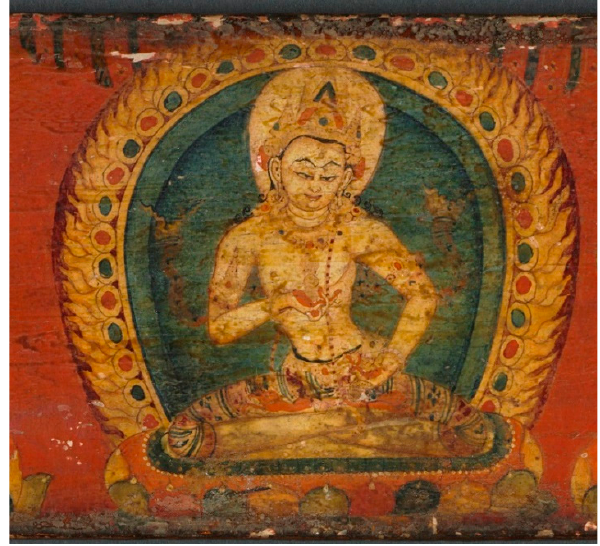
Figure 14. Vajrasattva, detail of bottom cover. Perfection of Wisdom in Eight Thousand Lines: A ṣṭ as ā hasrik ā Prajñ ā p ā ramit ā -s ū tra , 1119. Nepal. Gum tempera on wood. H: 6.5 cm. Cleveland Museum of Art, purchase from the J. H. Wade Fund, 1938.301.7.